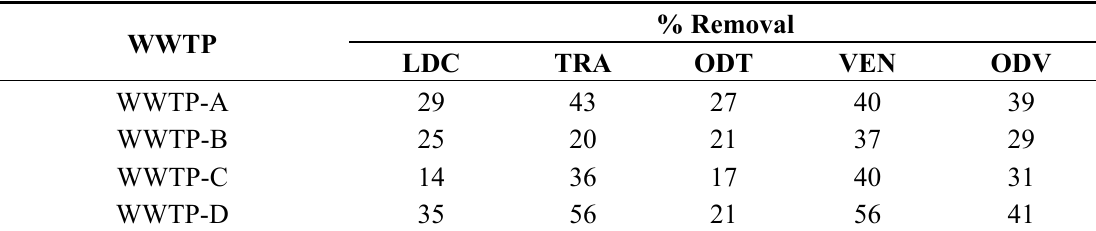
Table 2. Percentage of removal of target analytes during activated sludge treatment at the investigated WWTPs.